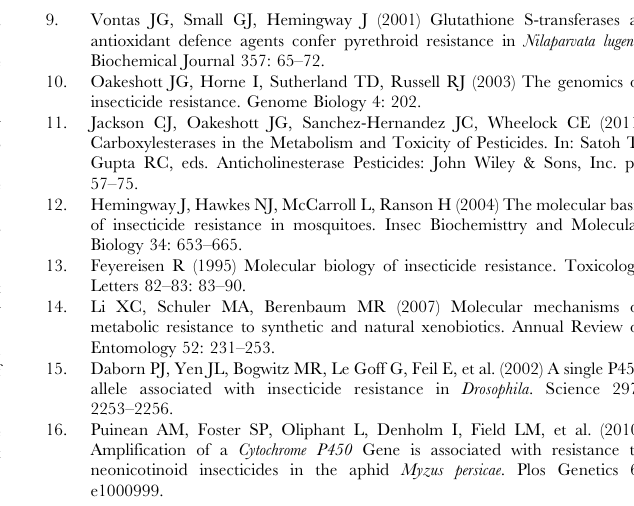
Table S2 Gene expression results for microarray and RT-qPCR methodologies. Table S3 Primers and probes used for insecticide resistance characterization. Table S4 Probe name, gene description, primers